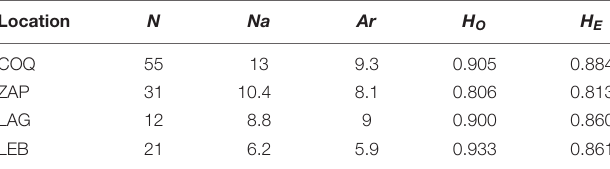
TABLE 3 | Mean genetic diversity estimates of G. chilensis per location.